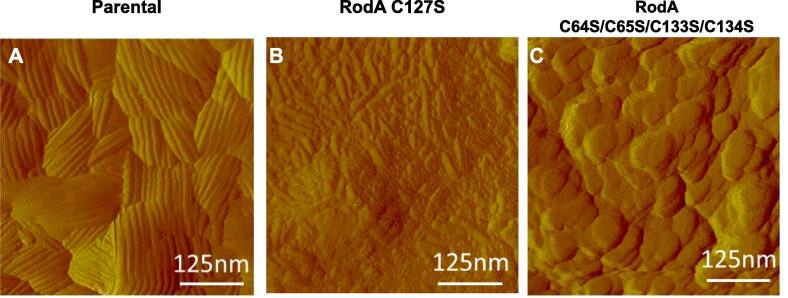
Cysteine mutations impair the presence of rodlets at the conidial surface. AFM deflection images showing the structure of conidial surface imaged in liquid conditions for: (A) the parental, (B) one cysteine (C127S) and (C) four cysteine (C64S/C65S/C133S/C134S) mutants.